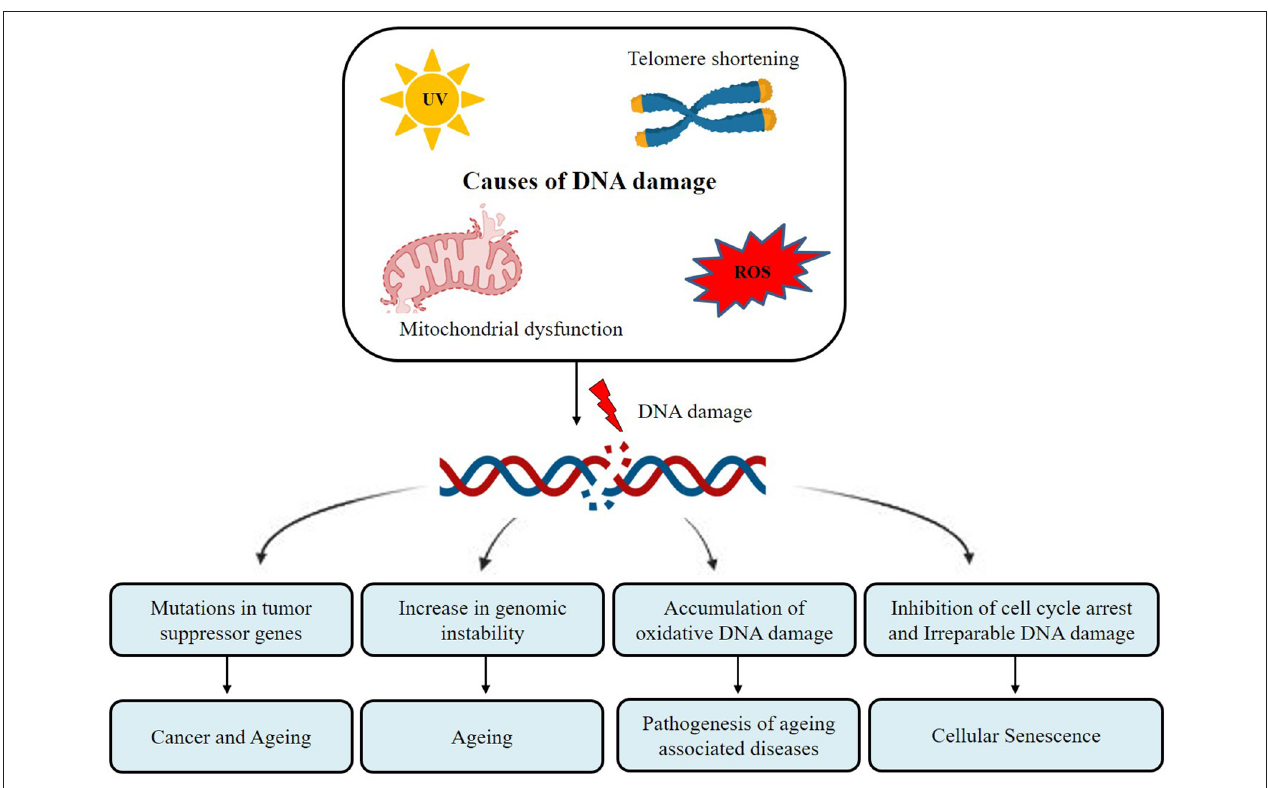
FIGURE 2 | Different types of DNA damage result in aging and associated diseases.